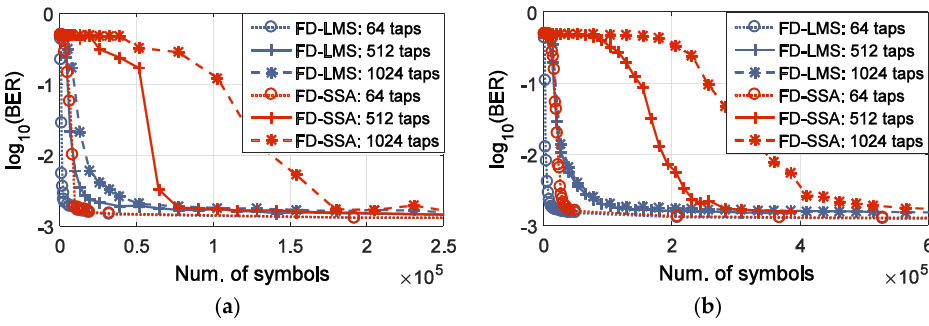
Figure 7. Convergence of the equalizers as a function of the number of symbols employed. ( a ) Convergence of the FD 2 × 2 LMS and SSA; ( b ) convergence of the FD 6 × 6 LMS and SSA.